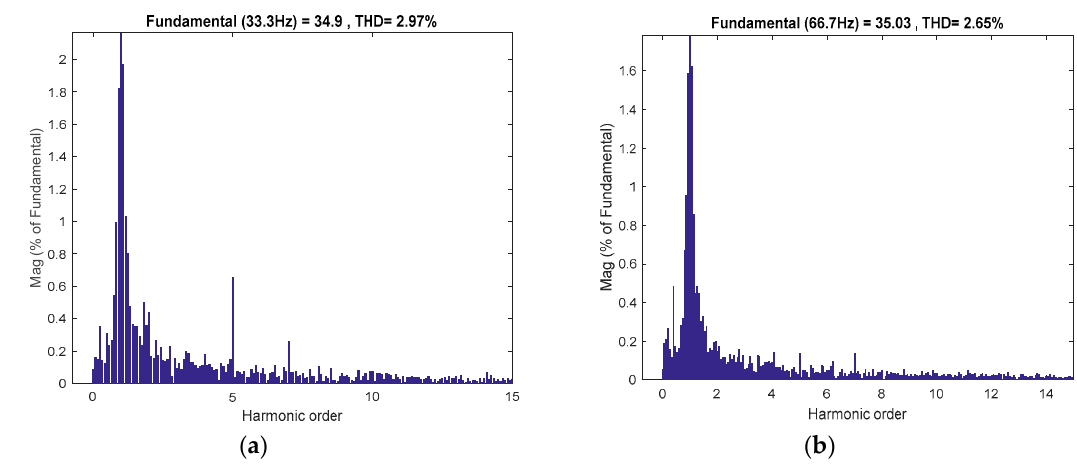
Figure 19. Phase A and D currents after adopting both feedforward voltage compensation and a resonant controller, ( a ) speed is maintained at 500 rpm, and ( b ) speed is maintained at 1000 rpm.